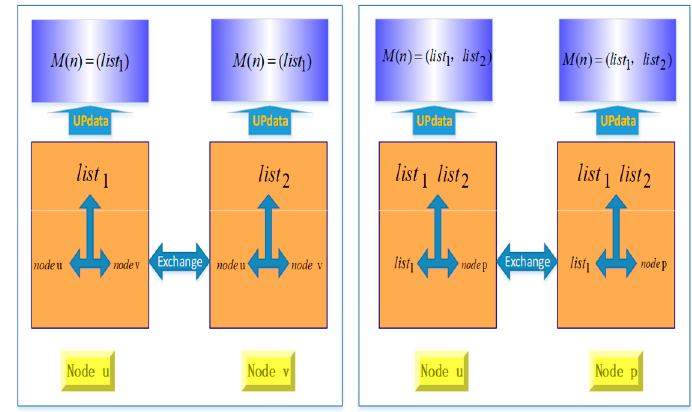
Figure 1. Information collection and update between mobile nodes in the networks.